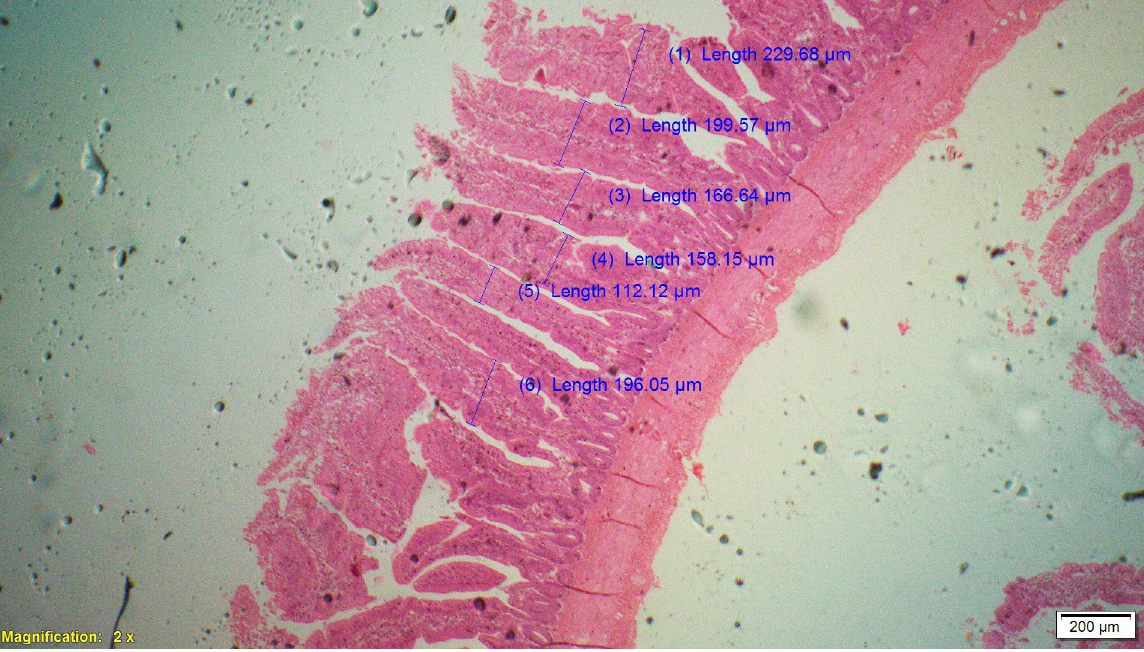
Fig 1. Photomicrograph of the cross section of Jejunum from control group (T1). H&E,